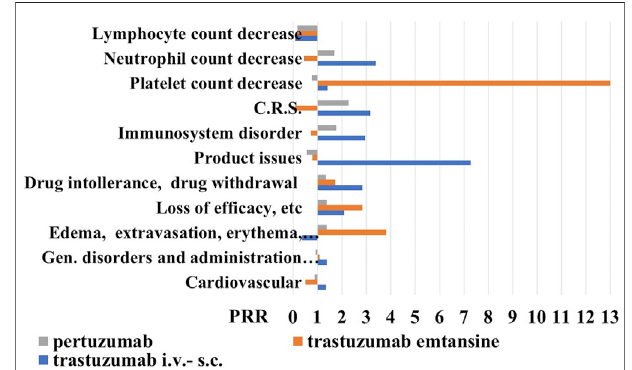
FIGURE 3 | Proportional reporting ratio (PRR) of reactions (all grade) in the 18 – 64-year-old population under anti-HER2 mabs treatment. Trastuzumab i.v.-s.c. formulations with X 2 > 4.612 for product issues, immune-system disorder, cytokine release syndrome (C.R.S.) and drug intolerance, and trastuzumab emtansine with X 2 > 4.522 for edema, extravasation, in fl ammation, and loss ofef fi cacy, and pertuzumab. PPRof cell biomarkers of in fl ammation (all grade) in the 18 – 64-year-old population under anti-HER2 mabs treatment. Trastuzumab emtansine showed X 2 > 5.121 for lymphocyte and platelet count decrease. PRR > 2 indicates a high risk of ADR for a speci fi c S.O.C.